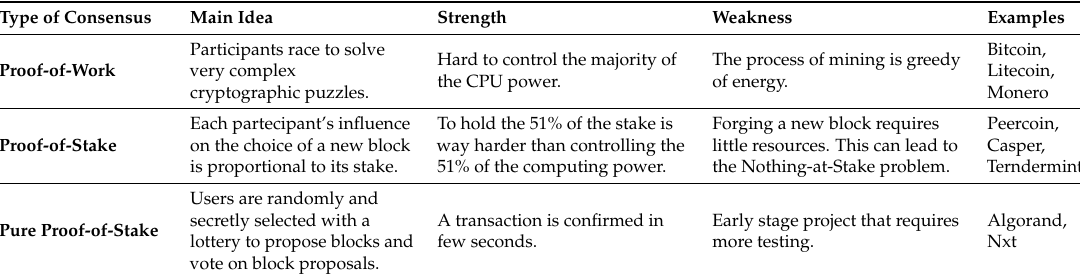
Table 1. Review of the most famous